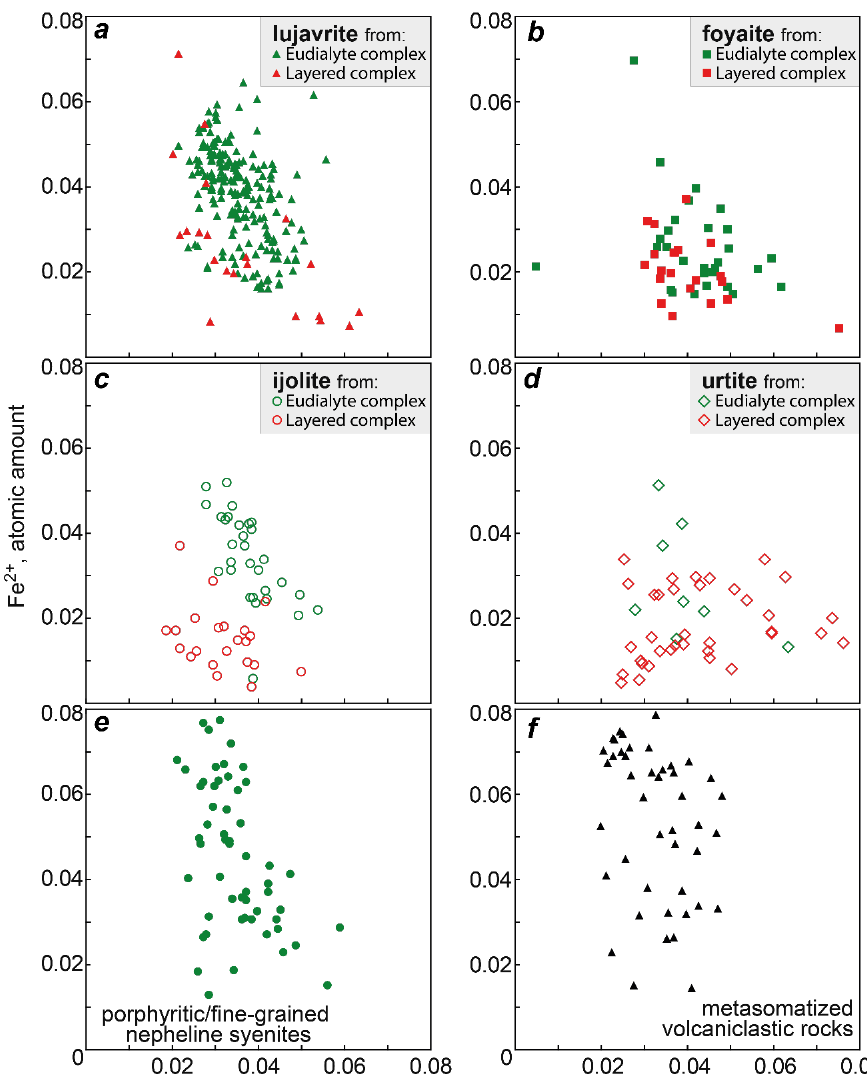
Figure 8. Atomic amount Fe 2+ vs atomic amount Mn in the EGM from different rocks of the Lovozero massif. ( a ) Fe 2+ vs Mn in the EGM from lujavrite; ( b ) Fe 2+ vs Mn in the EGM from foyaite; ( c ) Fe 2+ vs Mn in the EGM from ijolite; ( d ) Fe 2+ vs Mn in the EGM from urtite; ( e ) Fe 2+ vs Mn in the EGM from porphyritic/fine-grained nepheline syenites; ( f ) Fe 2+ vs Mn in the EGM from metasomatized volcaniclastic rocks.